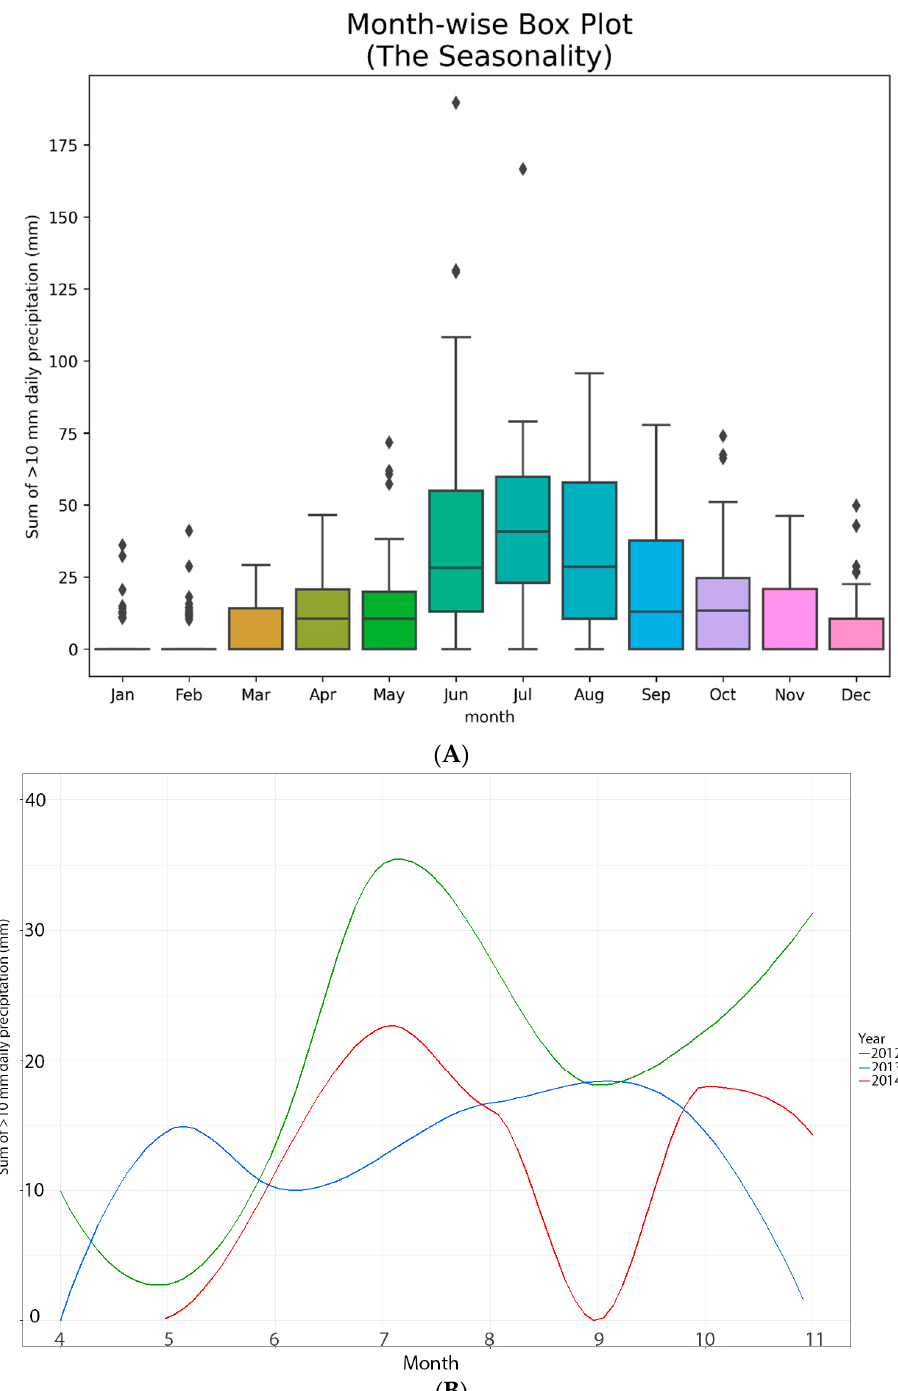
Figure 7. Seasonality (last decade) ( A ) and variability ( B ) of cumulative rainfall depth (mm.month − 1 ) for days with more than 10 mm for the summer-fall periods of 2012–2014 at the study sites (according to Kazan Federal university meteorological station data).